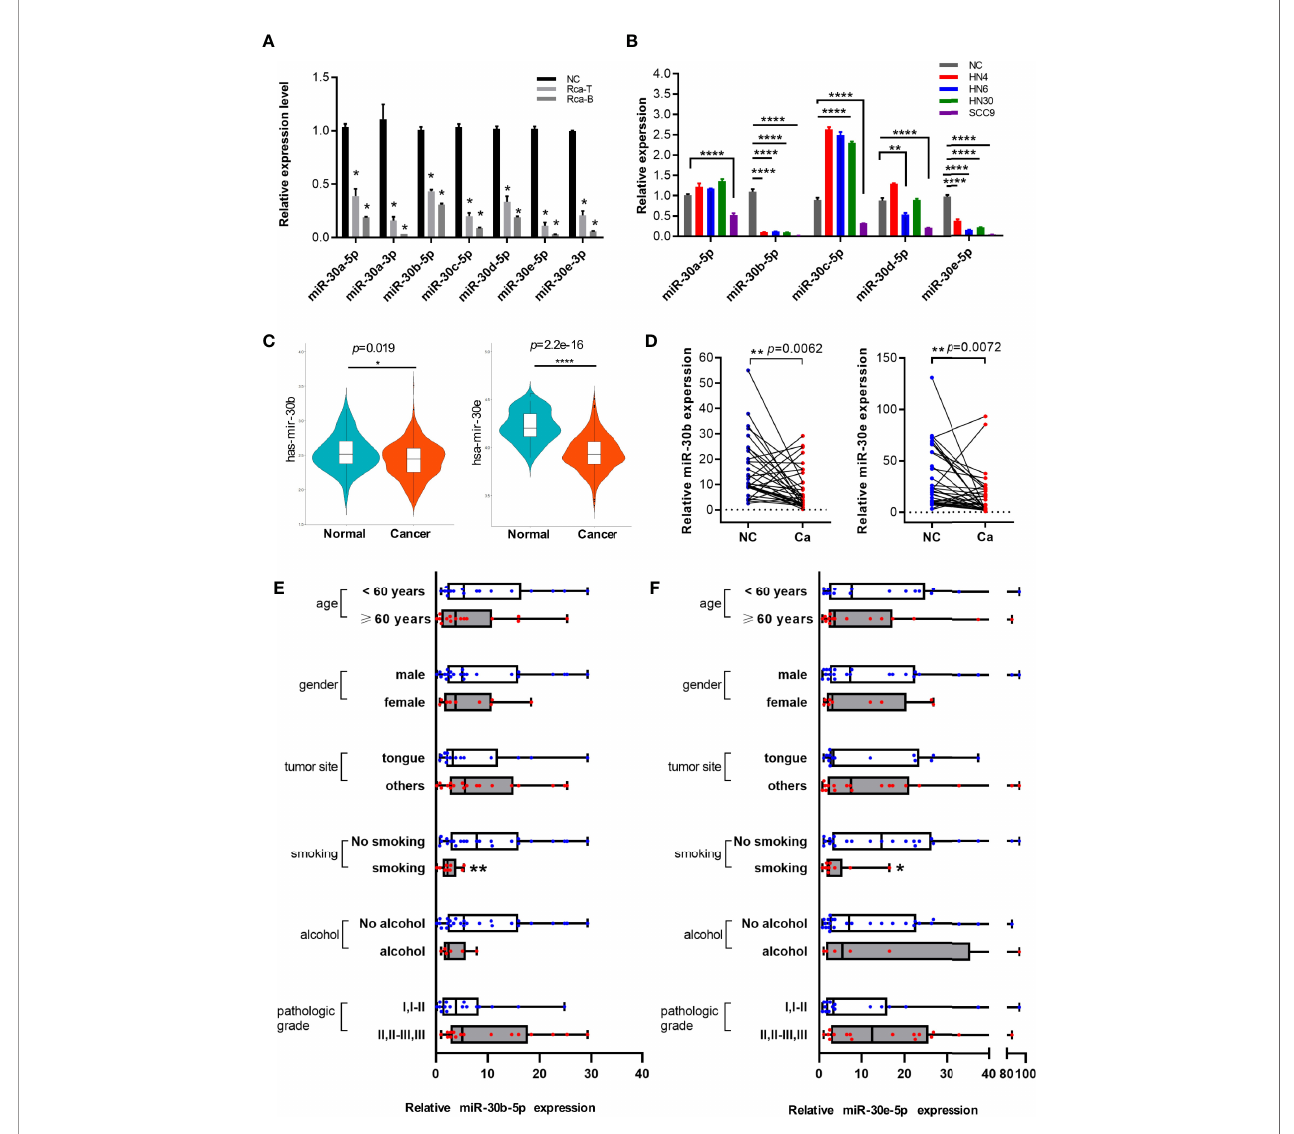
FIGURE 2 | The expression of miR-30 family was downregulated in HNSCC. (A) The relative expression level of miR-30 family in rat oral squamous cell lines. (B) The expression level of miR-30 family in HNSCC cell lines. (C) The expression tendency of miR-30b-5p and miR-30e-5p in HNSCC samples base on TCGA database. (D) The expression level of miR-30e-5p and miR-30b-5p in paired HNSCC tissues. (E, F) The relative expression level of miR-30b-5p or miR-30e-5p in oral tissues classi fi ed according to clinical data (age, gender, tumor site, smoking, alcohol, pathological grade). (* p <0.05, ** p <0.01, **** p